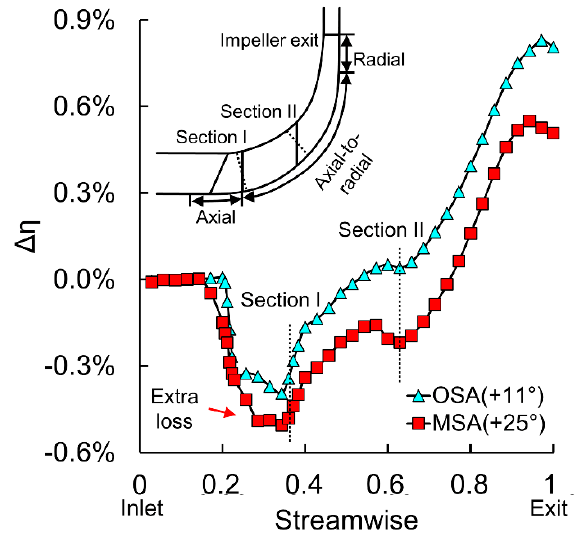
Figure 11. Streamwise efficiency deviation distribution.